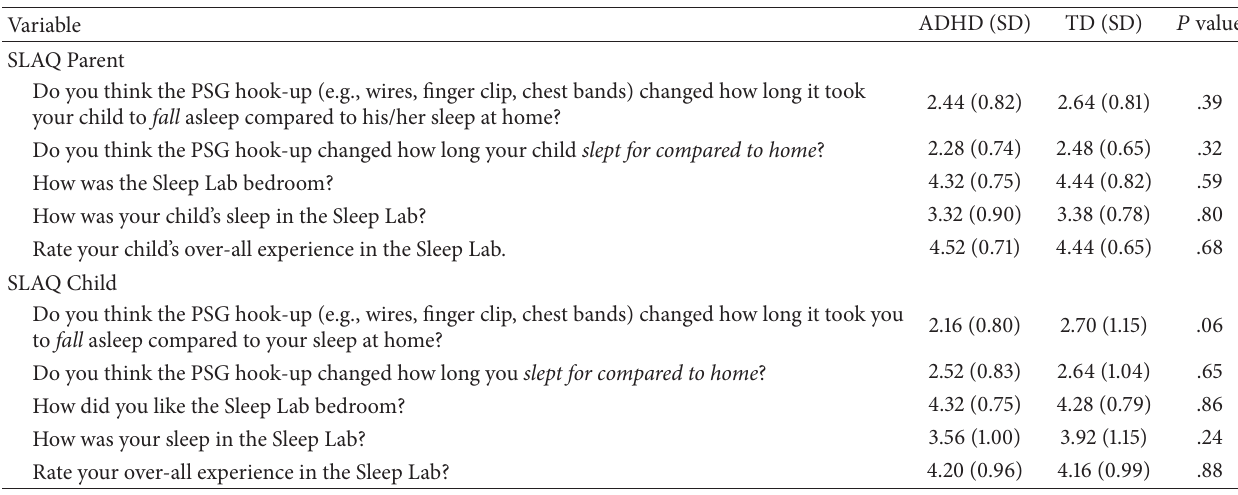
Table 1: Mean values on parent and child